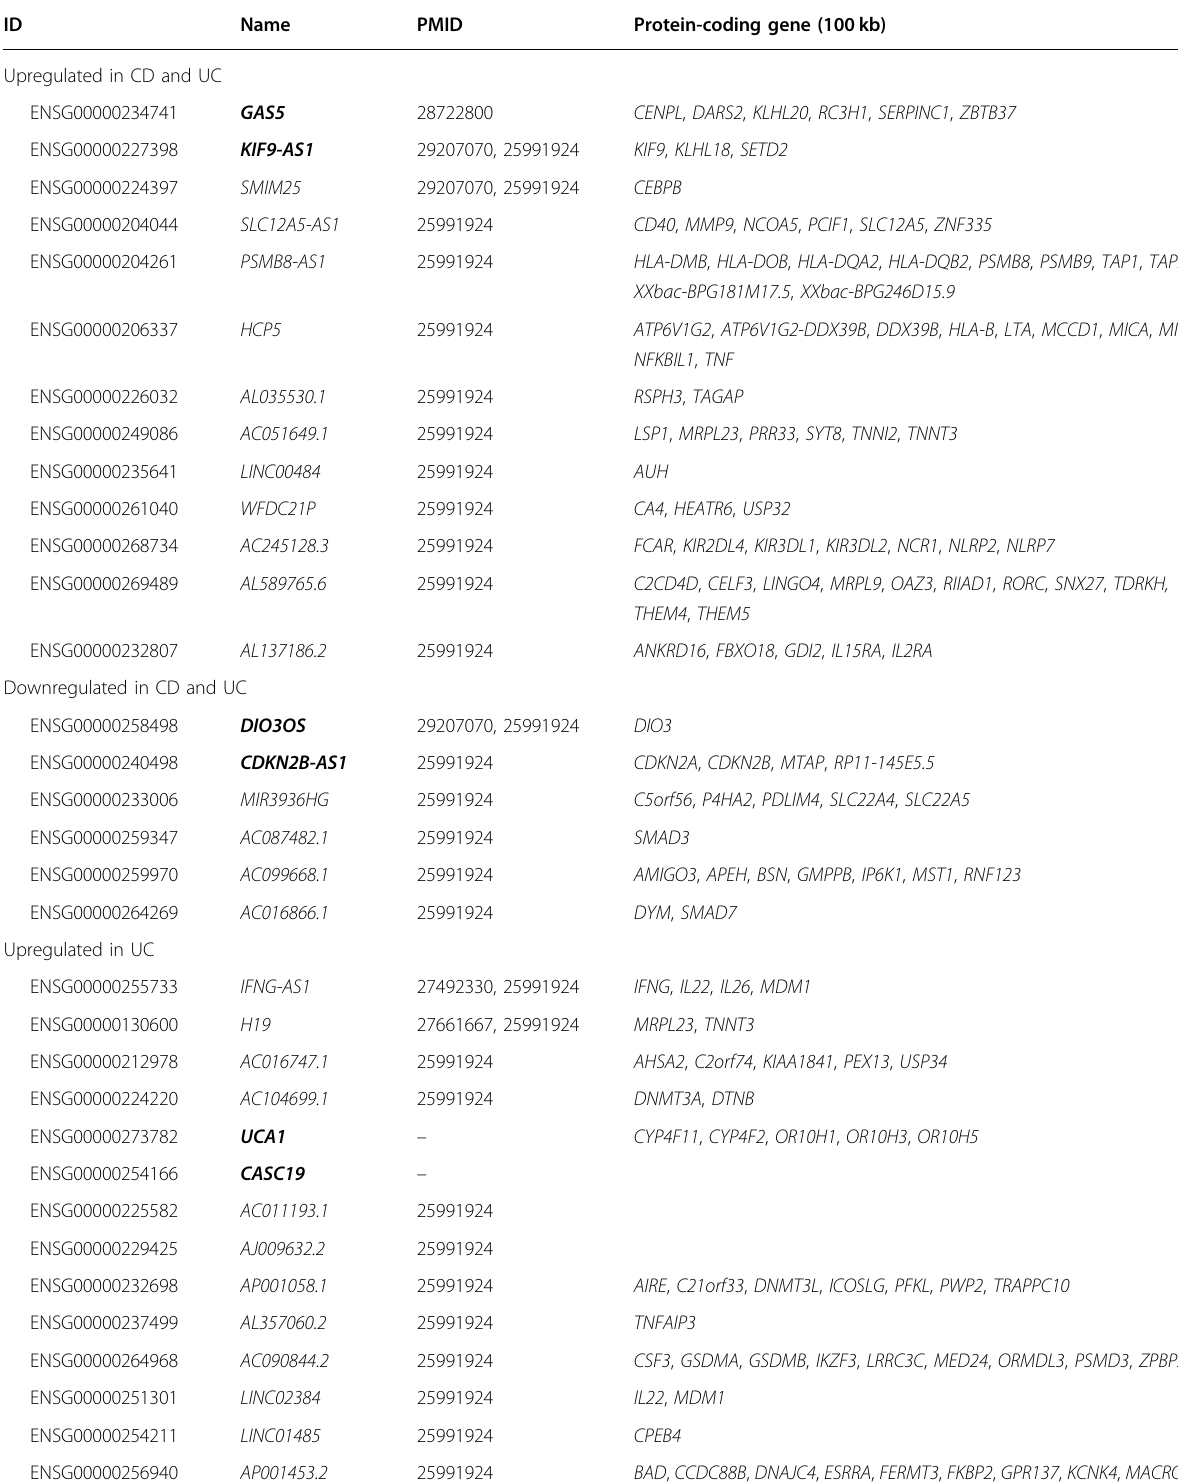
Table 2 List of IBD-associated lncRNAs alongside their 100 kb up- and downstream neighboring protein-coding